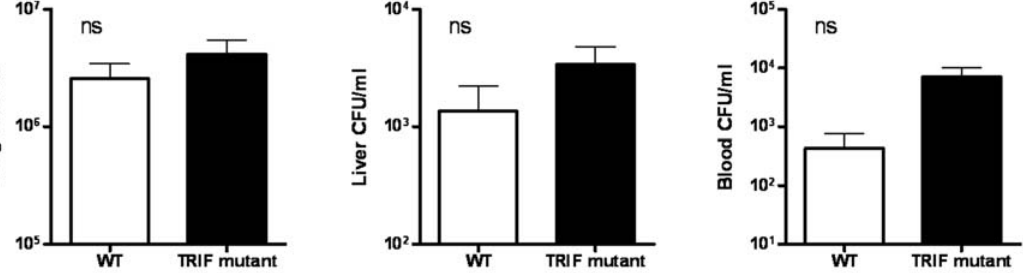
Figure 4. TRIF deficiency does not impact on bacterial outgrowth during experimental melioidosis. WT and TRIF mutant mice were intranasally infected with B. pseudomallei (5 6 10 2 CFU). Bacterial loads were measured 72 h after inoculation in lungs (A) , liver (B) and blood (C) . Data are mean 6 SEM (n=8 per group at each time point); ns denotes not significant. doi:10.1371/journal.pone.0003494.g004 infection with B. pseudomallei , we first measured cytokine levels in whole lung homogenates harvested from WT, MyD88 KO and TRIF mutant mice after intranasal infection with B. pseudomallei (Table 1) . 24 h after infection, pulmonary TNF a , MCP-1 and IL-10 were lower in MyD88 KO mice relative to WT mice (Table 1) . At 72 h after infection TNF a levels remained lower in MyD88 KO mice, while MCP-1 and IL-6 levels tended to be higher in these animals (Table 1) . In addition, histological samples of lungs obtained 24 and 72 hours after infection were semi-quantitatively scored on the extent of inflammation. Pulmonary inflammation was characterized by significant inflam- mation, pleuritis, peribronchial inflammation, oedema and